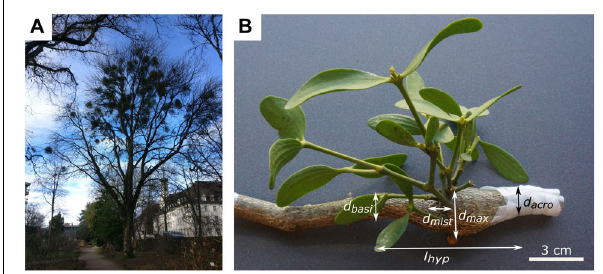
FIGURE 1 | The mistletoe Viscum album ssp. album parasitizing its host tree Aesculus flava . (A) Host tree in the Botanic Garden Freiburg, Germany, carrying mistletoe plants of various ages. (B) Hypertrophic host branch (brown) and a 5-year-old mistletoe (green). The maximum diameter of host hypertrophy ( d max ), branch diameter acropetally to hypertrophy ( d acro ) , branch diameter basipetally to hypertrophy ( d basi ), diameter of mistletoe attachment ( d mist ), and length of hypertrophy ( l hyp ) are